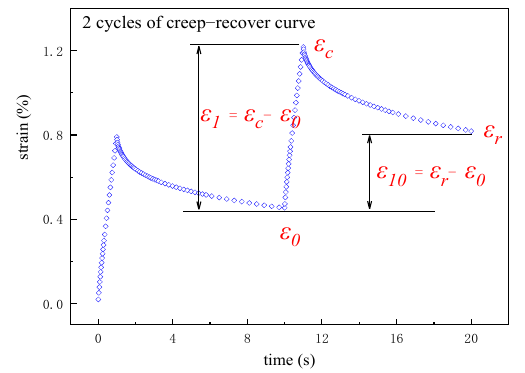
Figure 2. Strain values in the creep − recovery curves. In Figure 2, ε 0 is the initial strain value at the beginning of the creep portion of each cycle, %; ε c is the strain value at the end of the creep portion of each cycle, %; ε r is the strain value at the end of the recovery portion of each cycle, %; the adjusted strain value